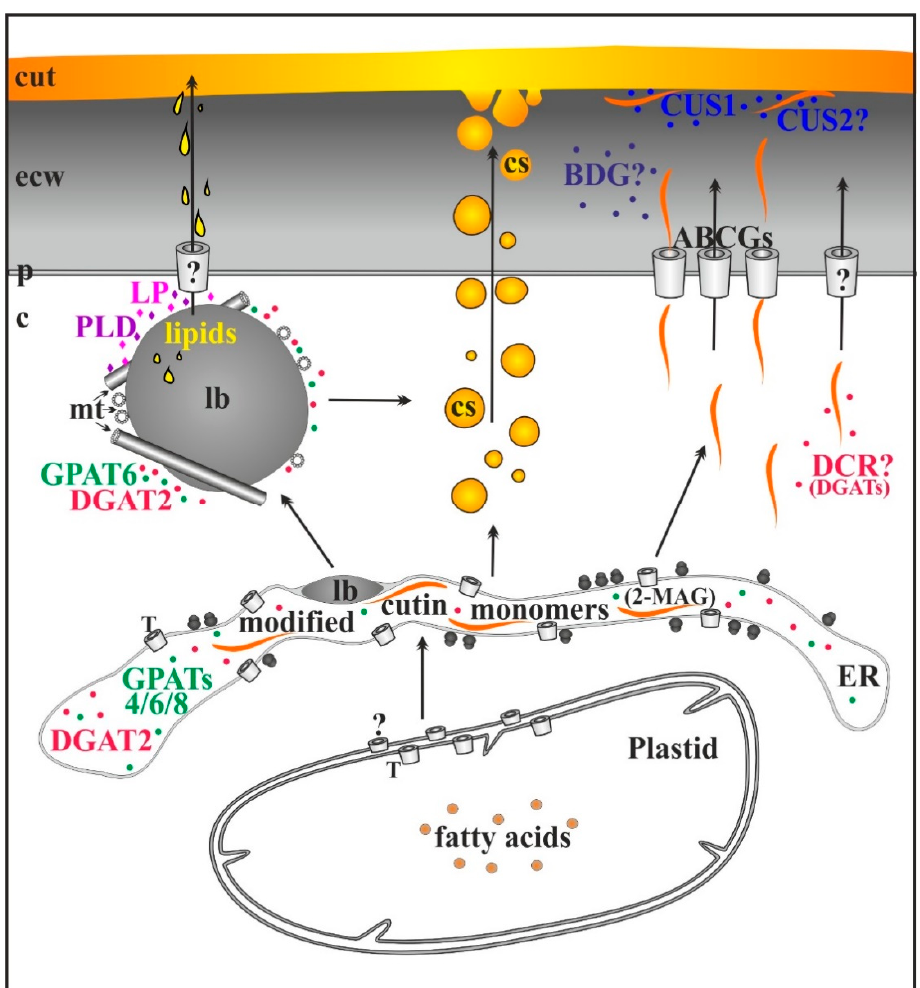
Figure 1. Scheme of complementary mechanisms of cutin biosynthesis by enzymes and cutinsomes. ATP-binding cassette transporters of the G subfamily (ABCGs); c, cytoplasm; cut, cuticle; cs, cutinsome bordered with a shell (black ring) and without it; enzymes participating in cutin biosynthesis: BODYGUARD (BDG), CUTIN SYNTHASEs (CUSs), DEFECTIVE IN CUTICULAR RIDGES (DCR), diacylglycerol acyltransferases (DGAT2) and glycerol-3-phosphatase-CoA acyltransferases (GPATs); ecw, external cell wall; ER, endoplasmic reticulum; lb, lipid body; LP, lipase; 2-monoacyl glycerol (2-MAG); mt, microtubule; p, plasmalemma; PLD, phospholipase D; T, transporters; question marks, possible involvement.